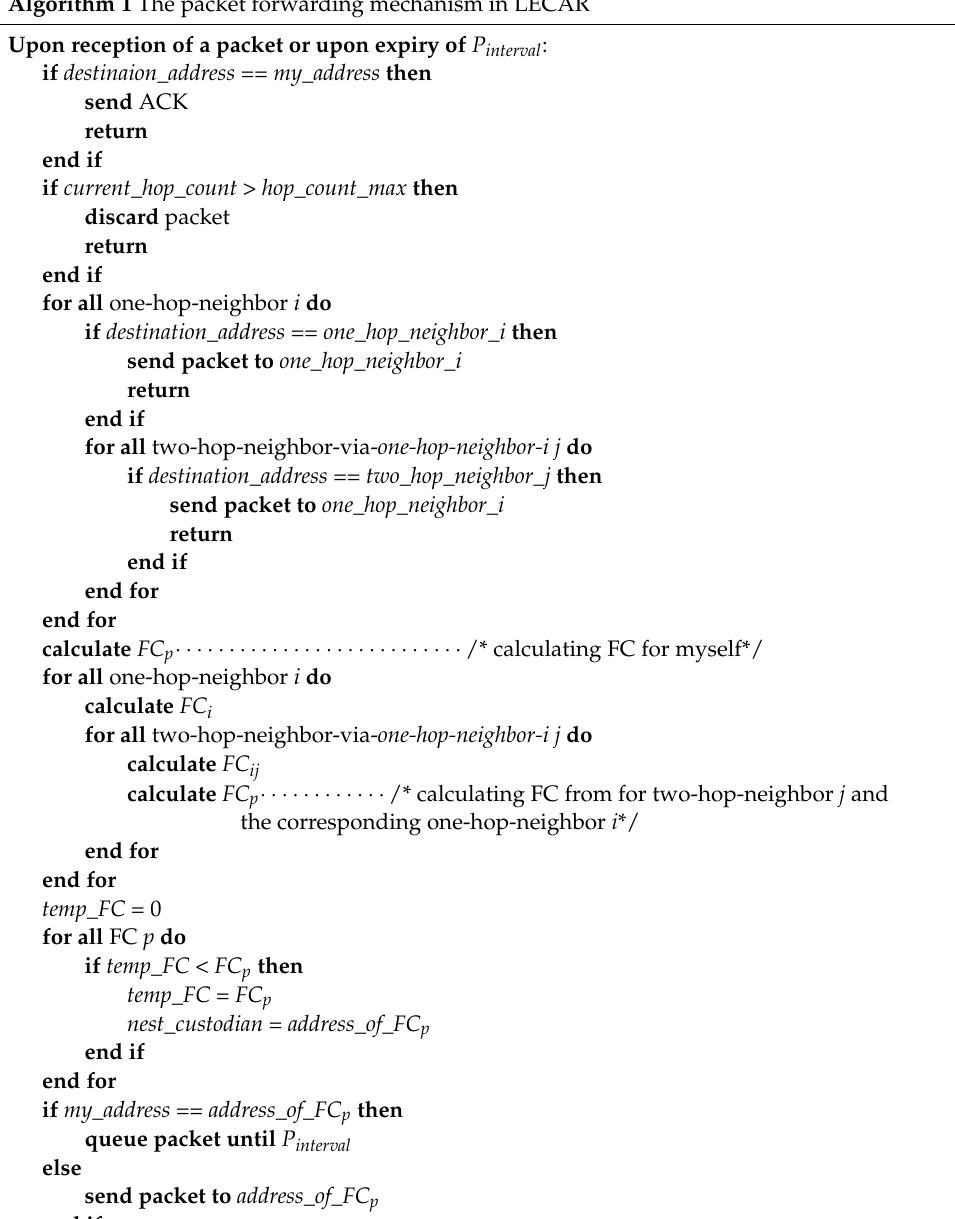
Algorithm 1 The packet forwarding mechanism in